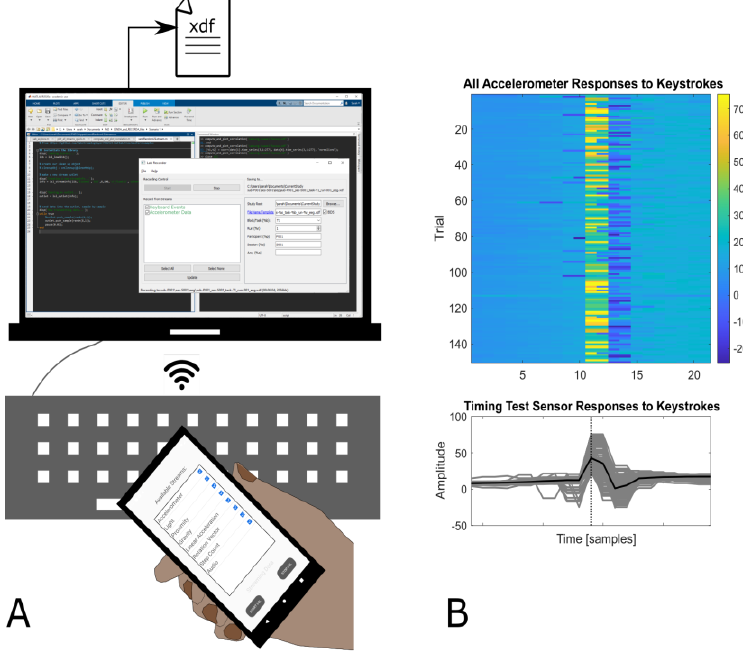
Figure A1. ( A ) Illustration of the timing test. A smartphone running Send-a was used to stream accelerometer data. On PC, two programs were running: a keyboard-capture tool creating markers for every key-press event and LabRecorder to record sensor data together with markers from PC. In the timing test, the phone was used to hit the space bar, which created a marker and an accompanying sensor response in the phone. ( B ) The upper plot shows all timing test responses vertically stacked. Each line shows the response of one trial, 20 ms of data around the marker indicating a key-press. The lower plot shows the average (bold black line) as well as every single sensor response (grey lines) in the time domain. The vertical dashed line indicates the position of the keyboard event